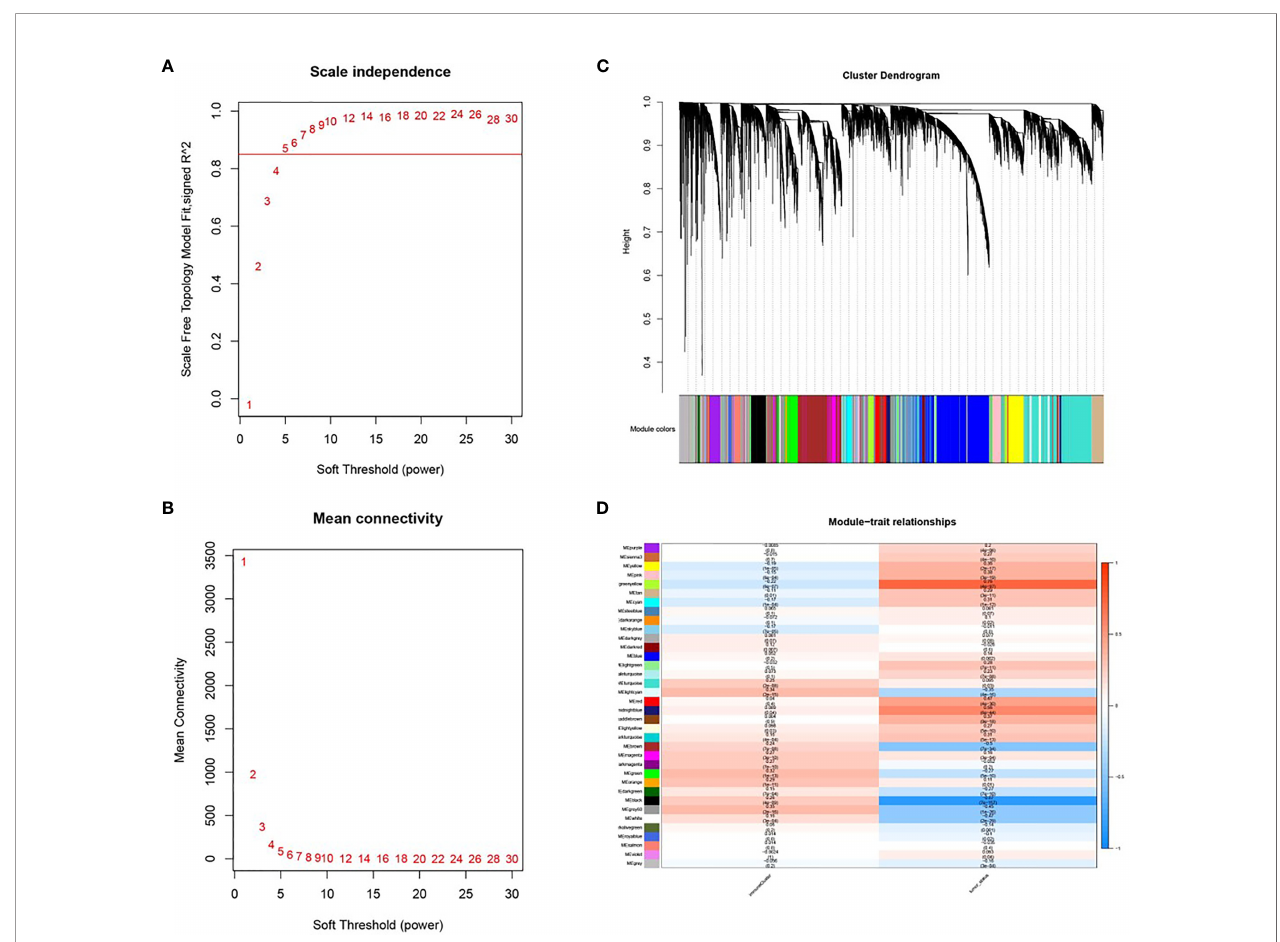
FIGURE 4 | Co-expression modules based on WGCNA screening. (A, B) Soft threshold screening ( b =5); (C) Clustering dendrogram and module colors; (D) Heat map of correlation between module feature genes and clinical features, columns represent colors and rows represent clinical features.